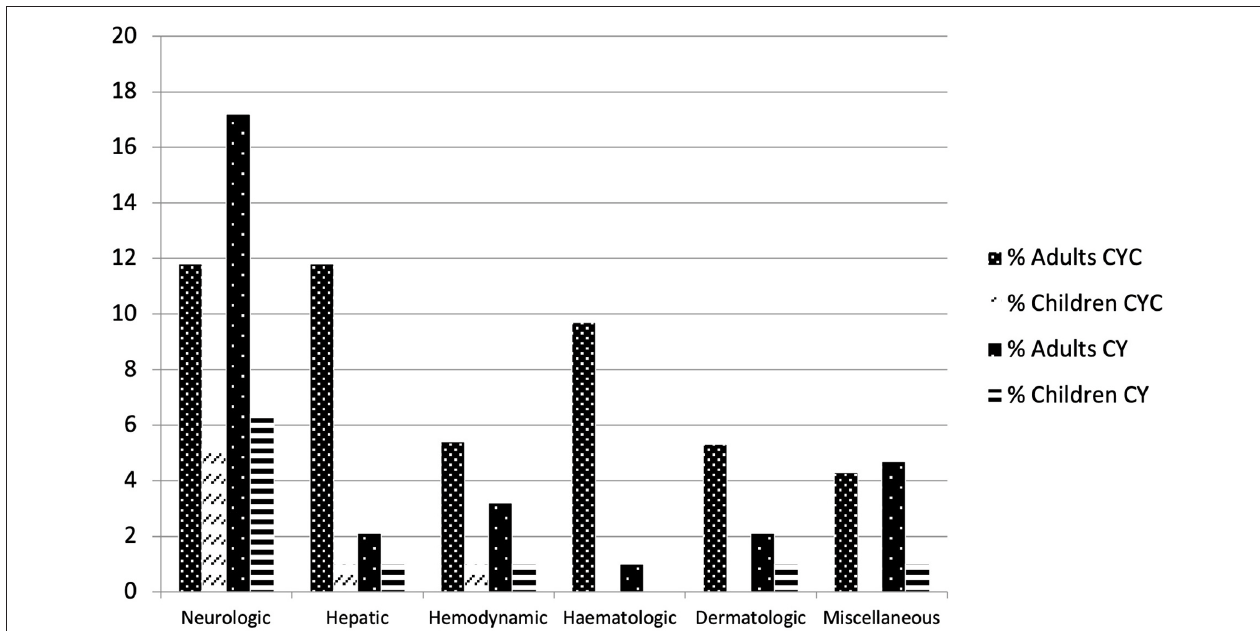
FIGURE 2 | Cyproheptadine adverses effects in adults or children in the French pharmacoviligance database, with cyproheptadine (CY) as monotherapy or with concomitant medications (CYC) (data are percentage of 93